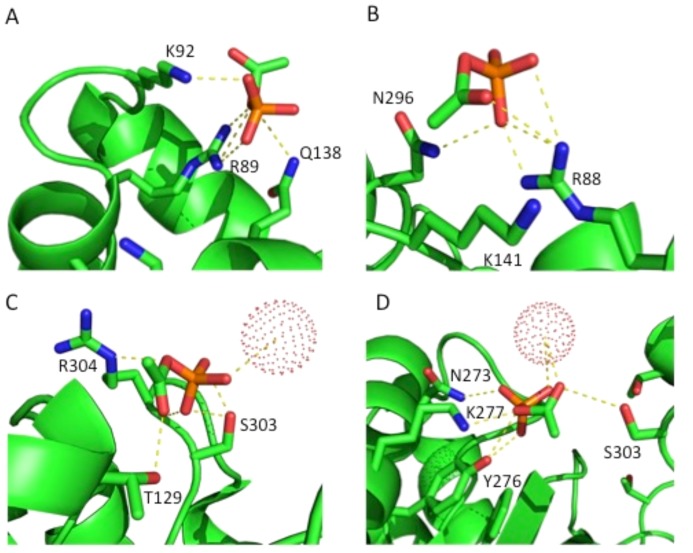
Phosphotransacetylase (Pta) from Bacillus subtilis, with AcP bound in four distinct sites.The crystal structure of Pta from B. subtilis (PDB ID: 1XCO) was used to show the locations where acP bound the protein. Yellow dashed lines highlight the polar contacts with acP, phosphate is displayed in orange, nitrogen atoms are shown in blue, and oxygen atoms are in red. Dotted spheres represent water molecules.